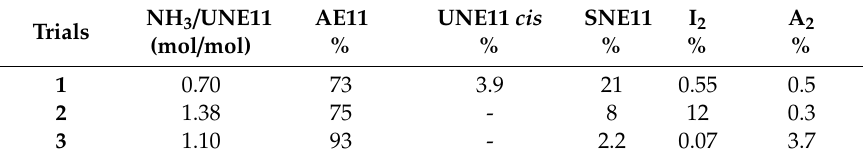
Influence of equivalents of ammonia on the conversion of UNE11 to AE11. H 2